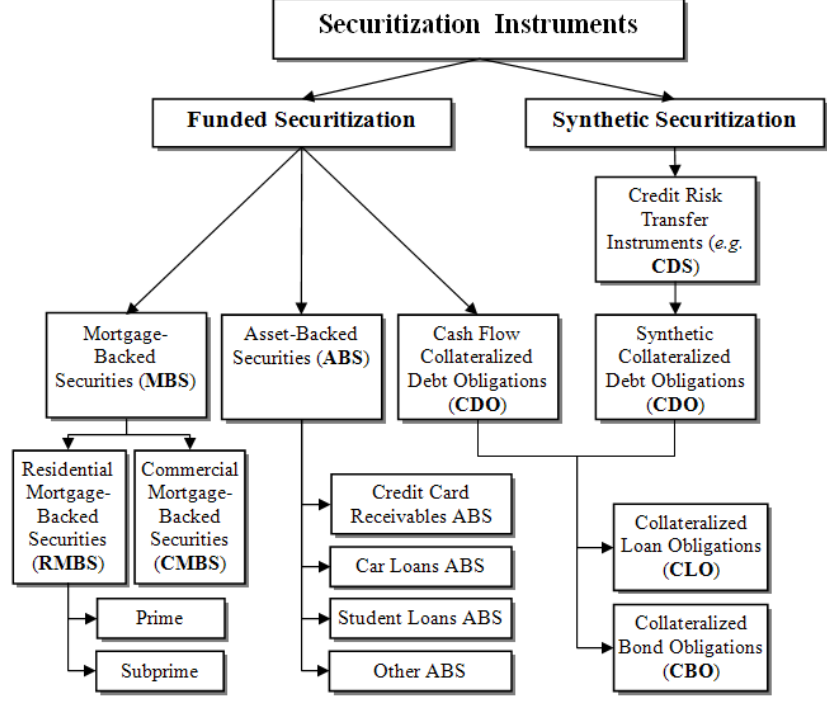
Fig. 3. Securitization